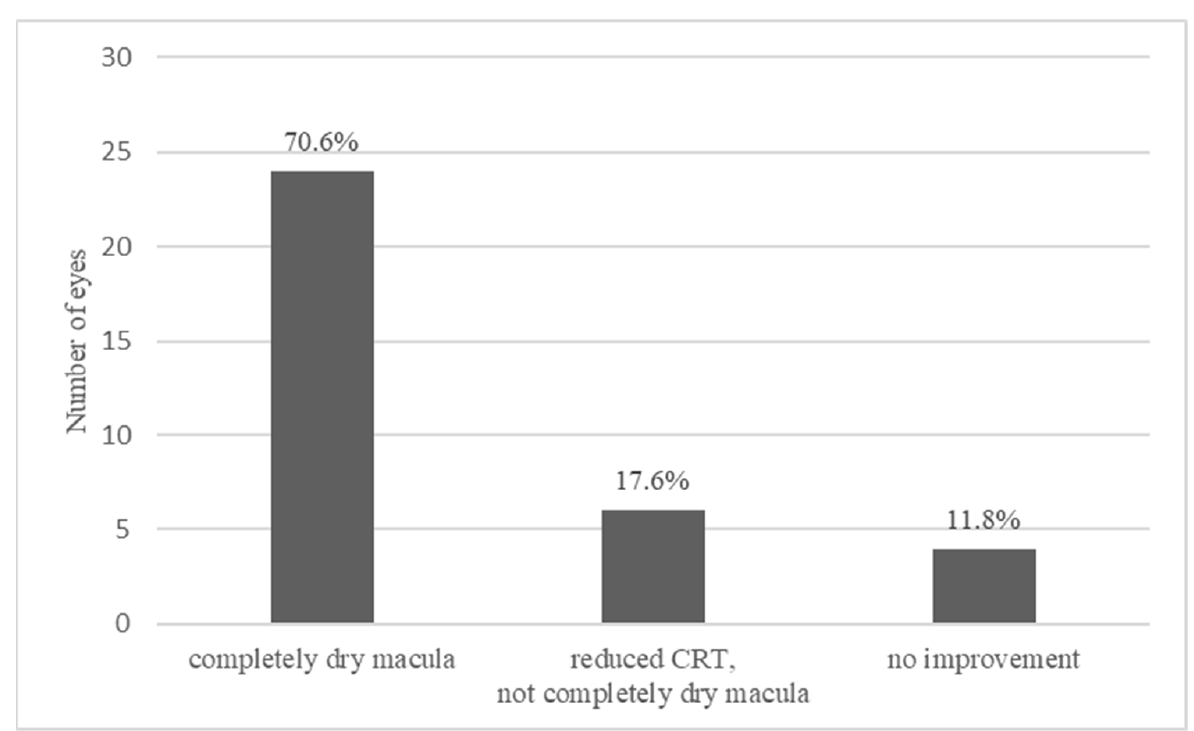
Figure 1. Extent of macula edema 1–3 months following the intravitreal injection of a FAc implant.